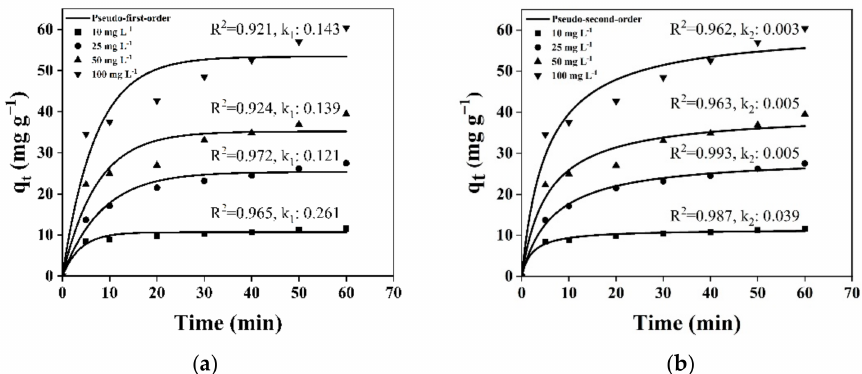
Figure 11. Nonlinear fitting for pseudo-first-order ( a ) and pseudo-second-order ( b ) models to phenol removal by WGTLs at various initial